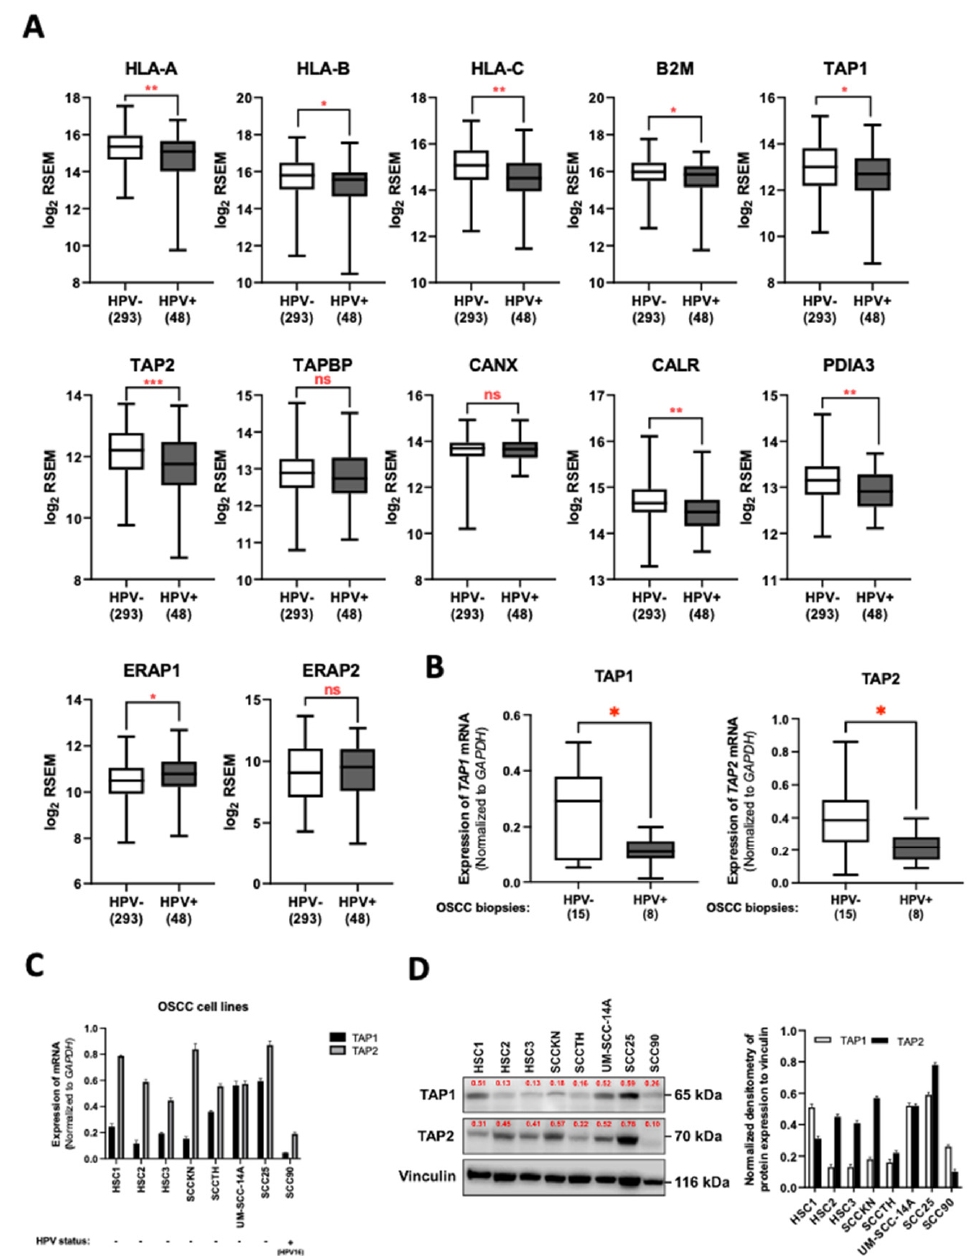
Figure 1. Expression of genes involved in MHC-I-dependent antigen presentation in OSCC samples of the HNSCC cohort from the TCGA database. ( A ) The expression of genes involved in the MHC-I heavy chain (HLA-A, HLA-B, and HLA-C), and other genes involved with MHC-I-dependent antigen presentation (B2M, TAP1, TAP2, TAPBP, CANX, CALR, PDIA3, ERAP1, and ERAP2) for HPV-positive and HPV-negative OSCC tissues. ( B ) The expression of TAP1 and TAP2 mRNA in OSCC biopsy samples with or without HPV infection was assessed by qRT-PCR. (C and D) The expression of TAP1 and TAP2 mRNA and proteins in the established OSCC cell lines was assessed by qRT-PCR ( C ) and immunoblotting ( D ). All experiments were carried out in triplicate, and at least three independent experiments were performed. The numbers in brackets refer to the number of samples included in each analysis. * p ≤ 0.05; ** p ≤ 0.01; *** p ≤ 0.001; ns—not significant.